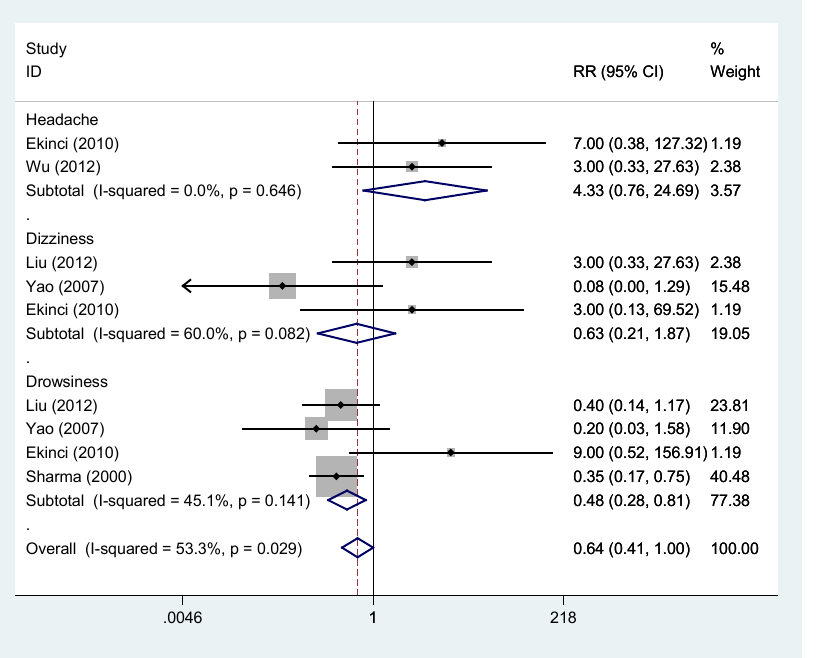
Figure 3: Forest plot of the risk of positive-operative headache, dizziness and drowsiness for ondansetron and droperidol groups. The gray squares and horizontal lines represent the RR and 95% CI, respectively. The area of the squares reflects the study specific weight (inverse of the variance). The blue diamond represents the pooled RR and 95% CI.